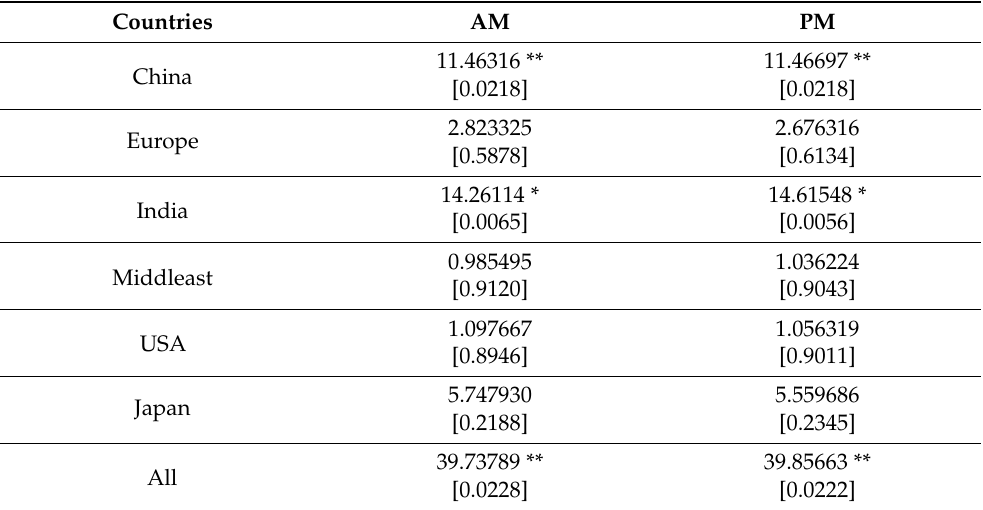
Table 5. Individual and collective impact of the independent variables on dependent variables. Countries AM PM